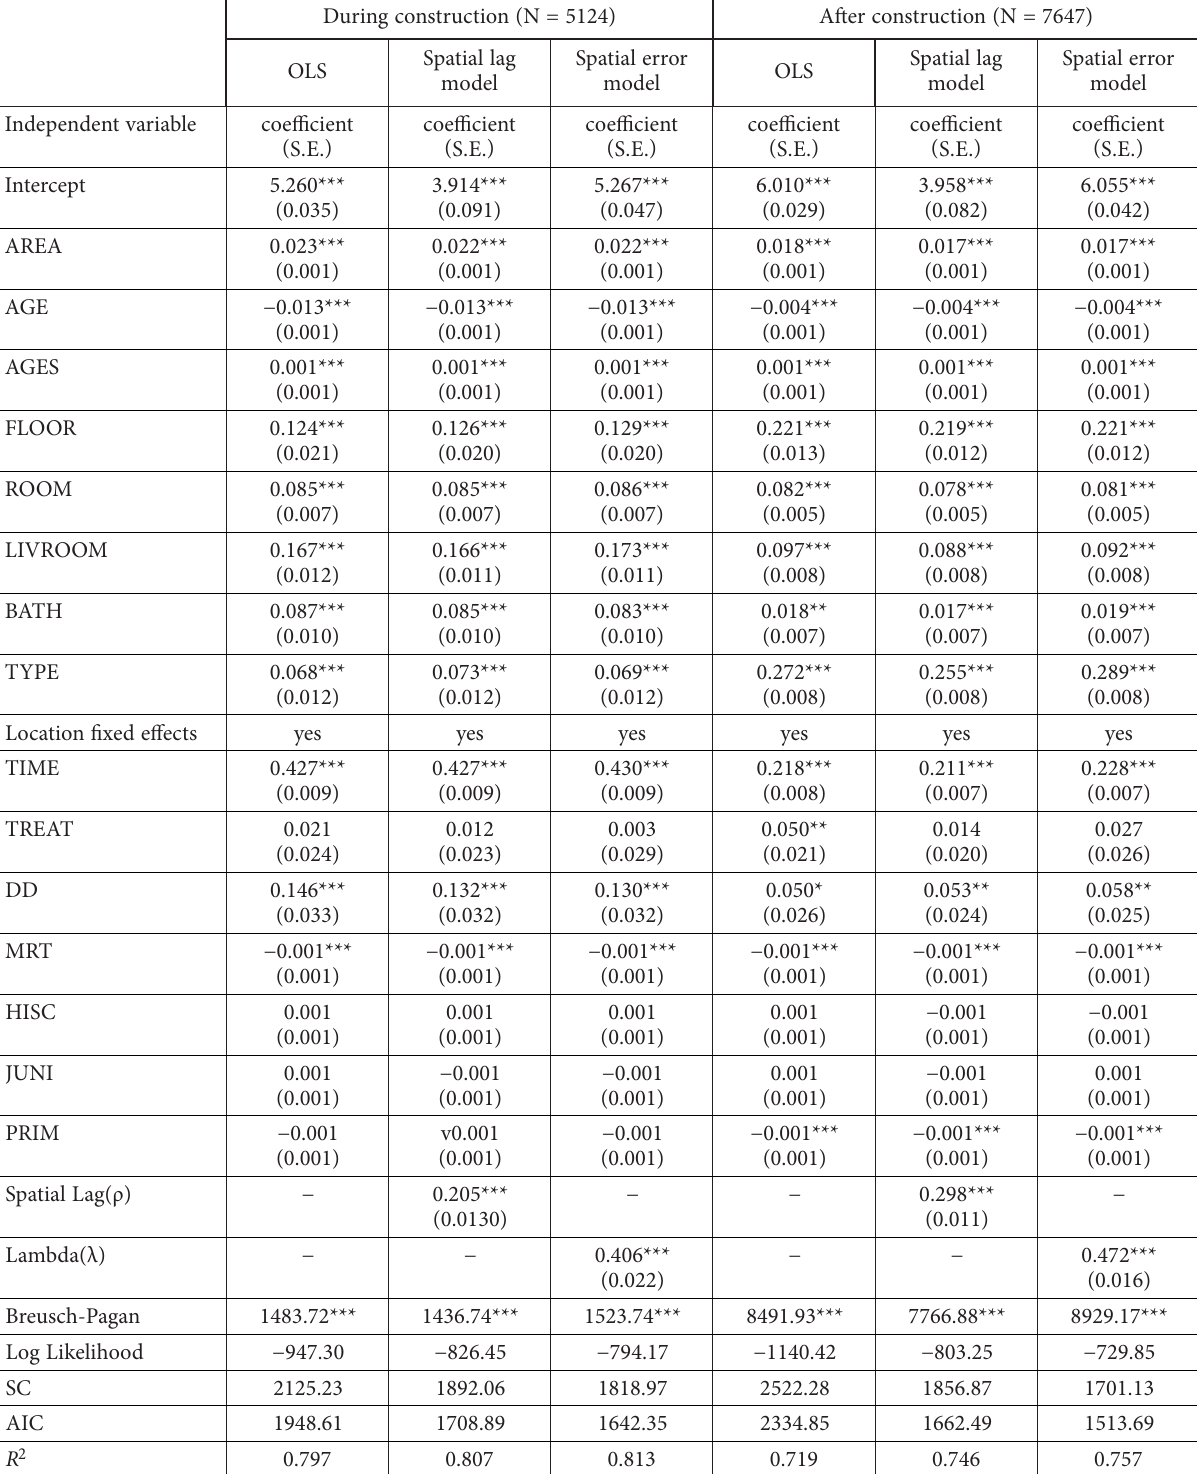
Table 7. Empirical results for the period during construction and after construction of luxury housing During construction (N = 5124) After construction (N =